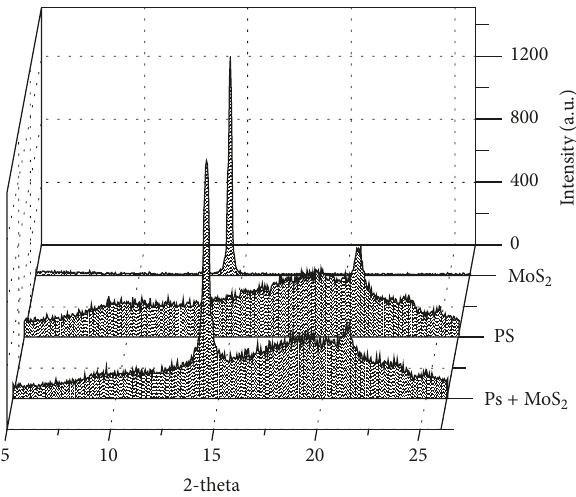
Figure 2: XRD results of PS, MoS 2 , and MoS 2 -PS composite.